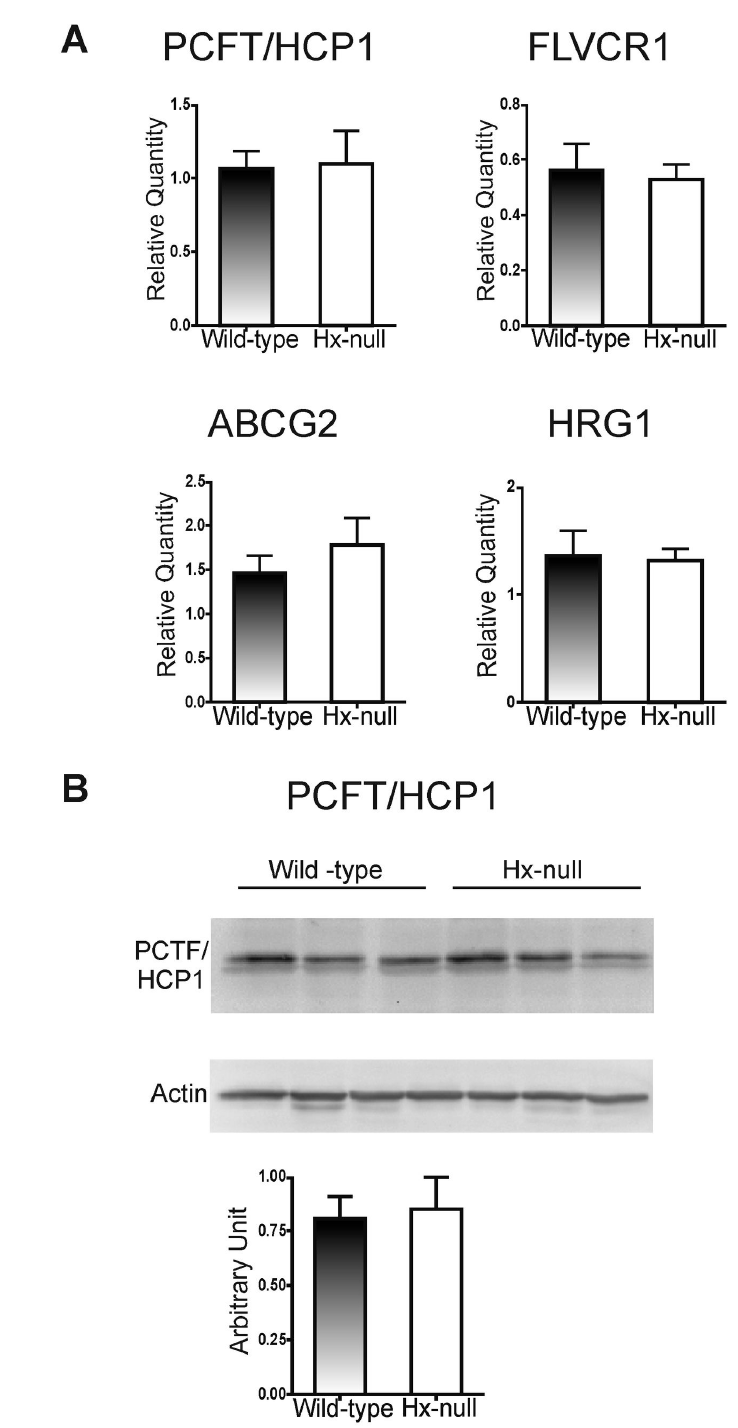
Figure 5. Hx deficiency does not affect the expression of duodenal heme transporters. (A) qRT-PCR analysis of PCFT/ HCP1, FLVCR1, ABCG2 and HRG-1 expression in the duodenum of wild-type and Hx-null mice. Transcript abundance, normalized to 18S RNA expression, is expressed as a fold increase over a calibrator sample. Data represent mean ± SEM, n= 6 for each genotype. (B) Representative Western blot of PCFT/HCP1 expression in the duodenum of wild-type and Hx-null mice. Band intensities were measured by densitometry and normalized to actin expression. Densitometry data represent mean ± SEM; n=3 for each genotype. Results shown are representative of 3 independent experiments. doi: 10.1371/journal.pone.0068146.g005 PLOS ONE |